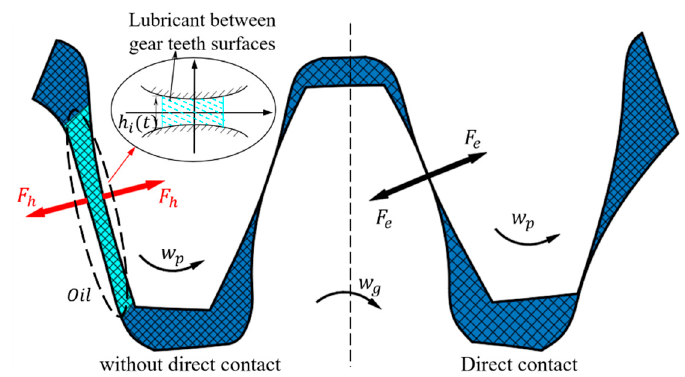
Figure 2. Schematic diagram of dynamic model of multi-gear rattling: (a) 1st gear; (b) 1st gear pre-selection 4th